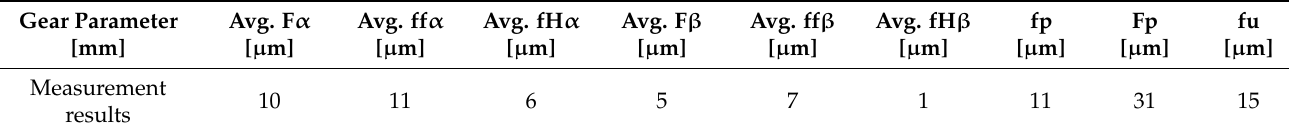
Table 2. The measurement results of the tolerance